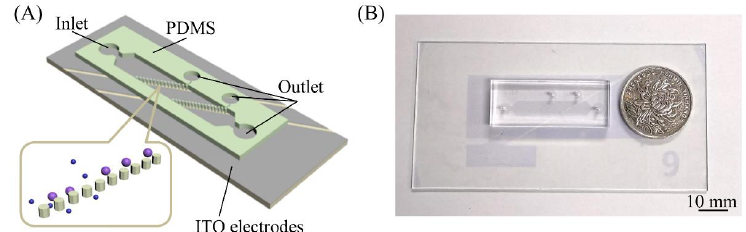
Figure 1. ( A ) Conceptual illustrations of the overall device and enlarged schematic; and ( B ) picture of the device.